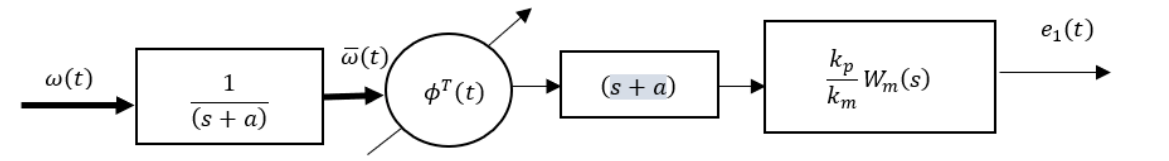
Figure 7. Simplified block diagram of the output error in the case of DMRAC for a plant of a relative degree 𝑛 ∗ = 2 .